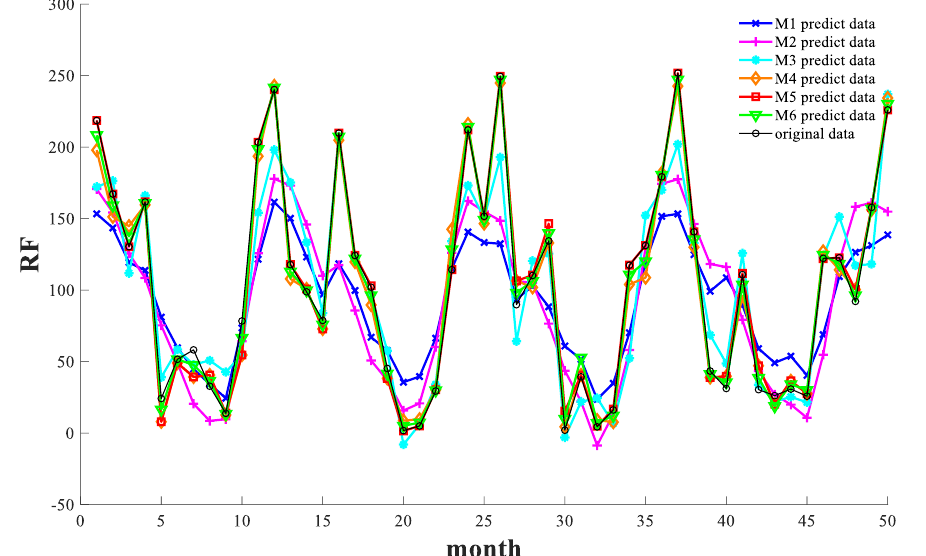
Figure 15. Predicting effect of the test rainfall (unit: mm). Table 3. Performance evaluation indices for M6–M9 models in training dataset.